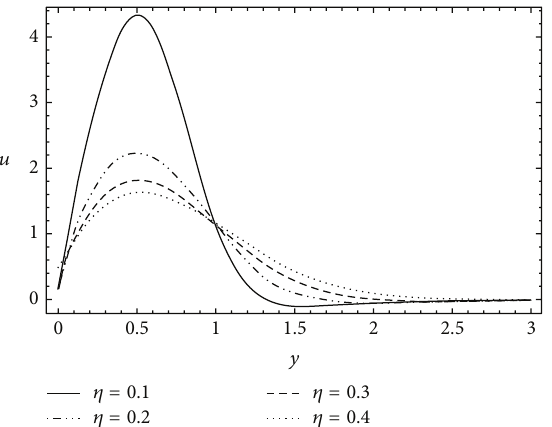
Figure 1: Velocity profiles for different values of 𝜂 corresponding to ramped temperature of the plate with 𝑡 = 0.9 (Pr = 0.71 ).